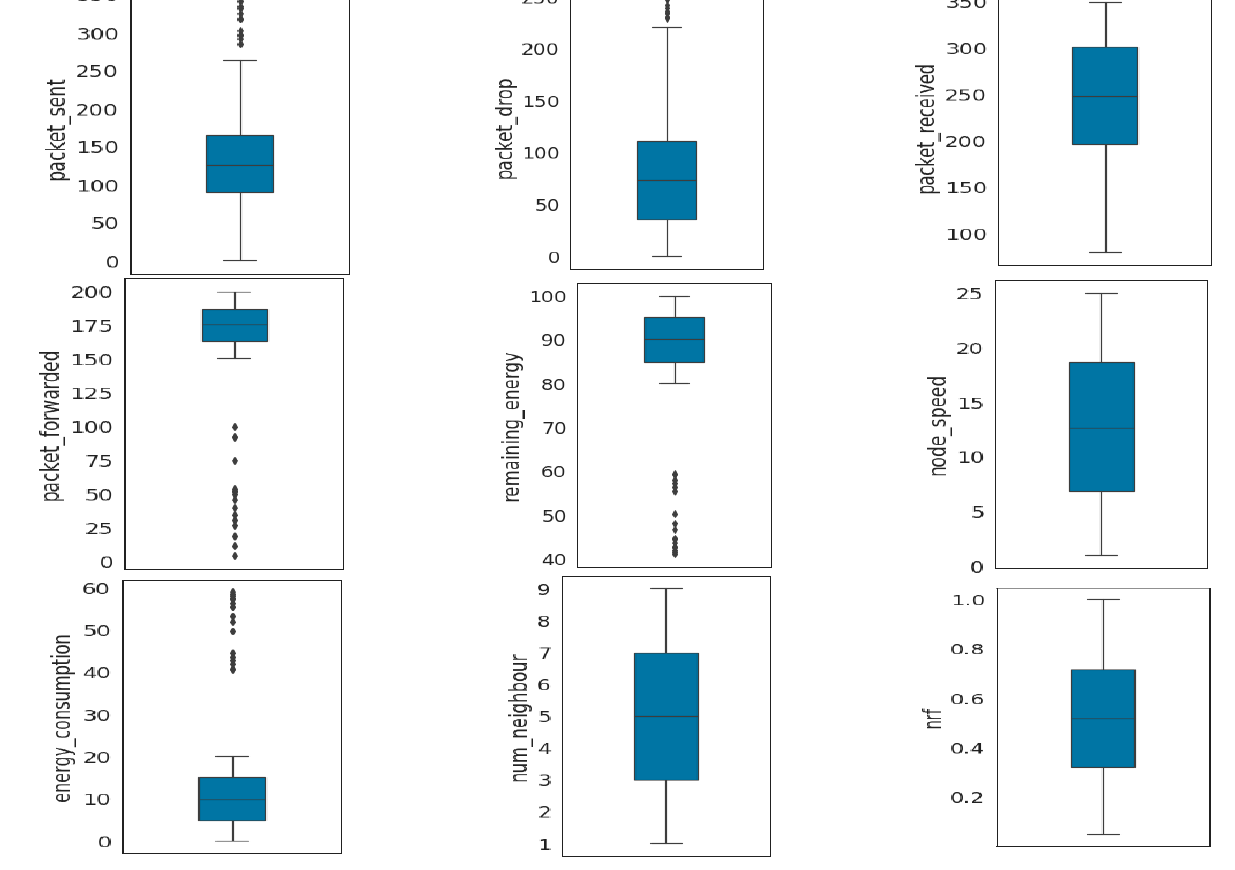
Figure 8. Boxplot representation of features.